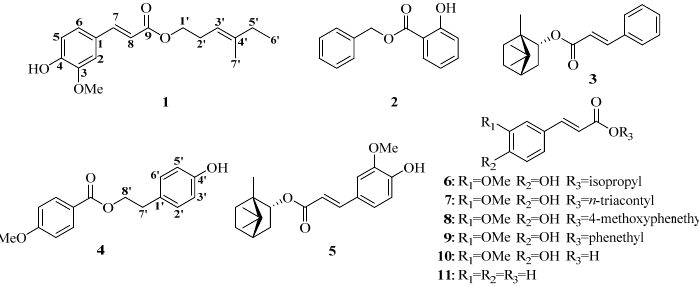
Figure 1. The structures of compounds 1 – 9 isolated from the roots and rhizomes of N. incisium and two related compounds 10 and 11 .